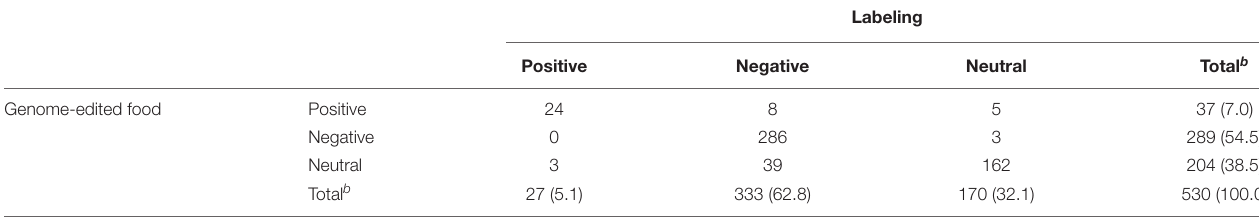
TABLE 4 | Types of sentiments on genome-edited food and its labeling expressed in each tweet posted from September 19 to 22, 2019 a